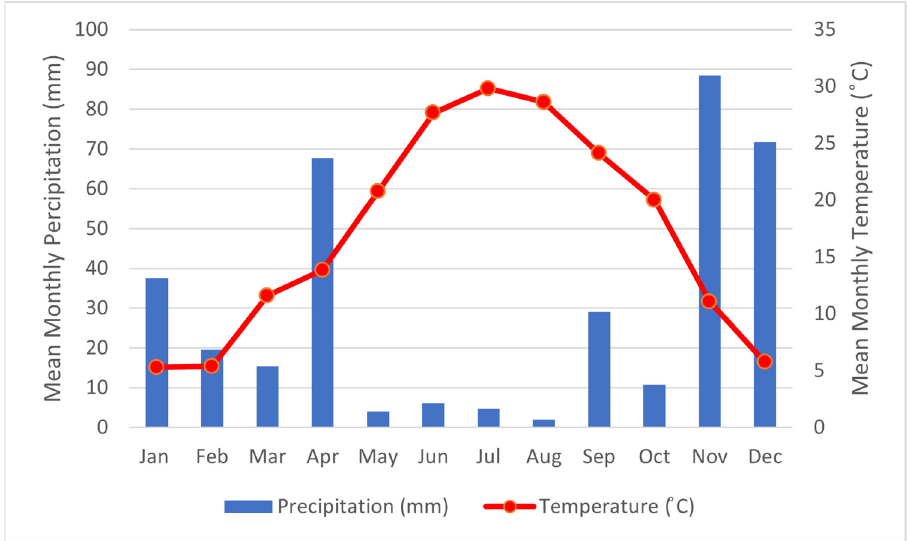
Figure 2. Climograph for the study area, based on data from Firuzkuh Station.